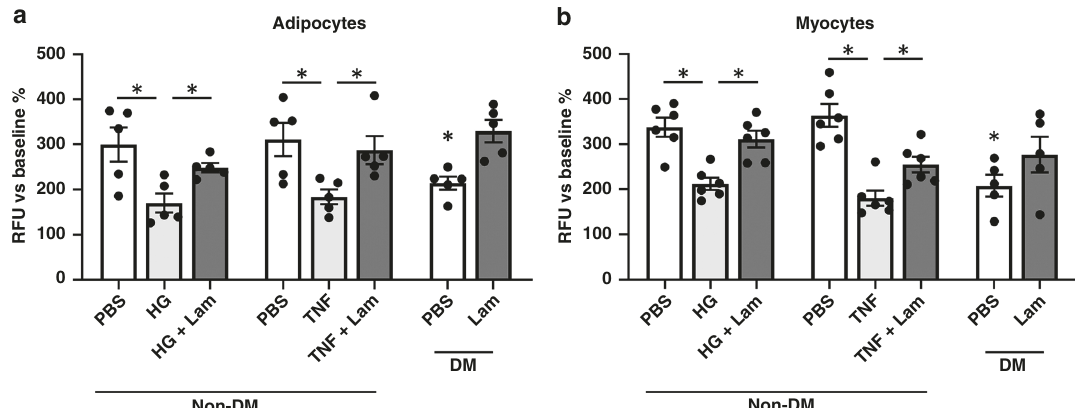
Fig. 4 Insulin-induced glucose uptake in human adipocytes and skeletal myocytes. The results of glucose uptake assays in human adipocytes a and in human skeletal myocytes b are shown. Cells from nondiabetic (Non-DM) persons were treated with either tumor necrosis factor (TNF; 2.5 nM) or with high glucose (25 mM) and high insulin (100 nM) (HG) to induce insulin resistance. Cells from diabetic (DM) and nondiabetic persons were treated with lamivudine (Lam; 100 μ M) or phosphate-buffered saline (PBS; vehicle). Glucose uptake measurements were performed by exposing cells to insulin (20 nM) using a fl uorescent derivative of glucose, and quanti fi ed as relative fl uorescence units (RFU) and normalized to baseline (prior to insulin treatment) levels of fl uorescence. Data are reported as mean ± s.e.m.* In Non-DM adipocytes, P = 0.02 (HG versus PBS), P = 0.01 (HG + 3TC versus HG), P = 0.01 (TNF versus PBS), P = 0.02 (TNF + 3TC versus TNF), two-tailed unpaired Student t test. In DM adipocytes, P = 0.02 (3TC versus PBS), two- tailed paired Student t test. n = 5 samples per group ( a ). In Non-DM myocytes, P < 0.001 (HG versus PBS), P = 0.001 (HG + 3TC versus HG), P < 0.001 (TNF versus PBS), P = 0.01 (TNF + 3TC versus TNF), two-tailed unpaired Student t test. In DM myocytes, P = 0.03 (3TC versus P BS), two-tailed